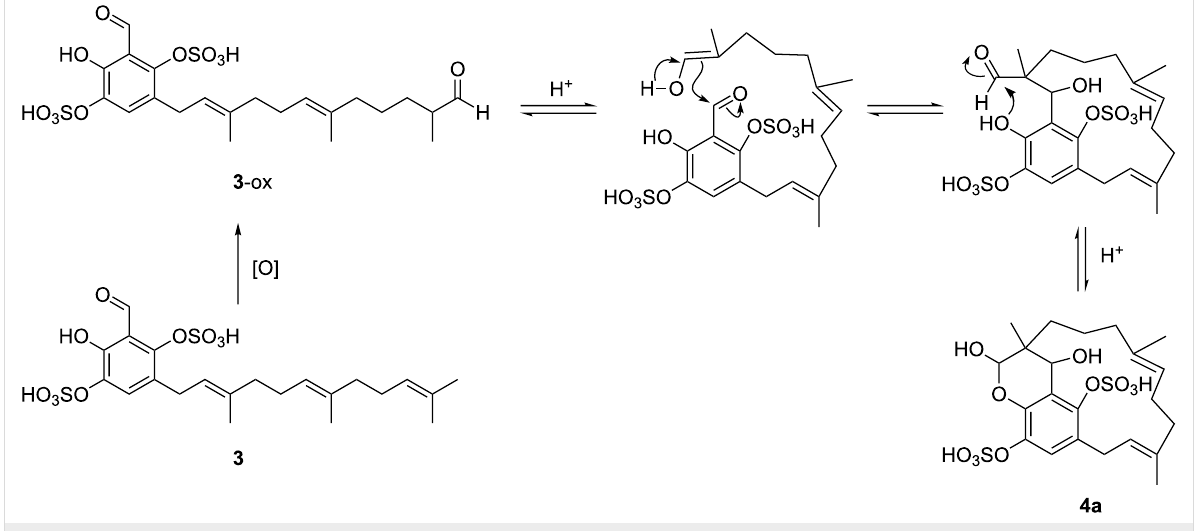
Figure 7: Proposed biogenesis of 4a starting from the hypothetical precursor 3 -ox with an acyclic sesquiterpenoid part.